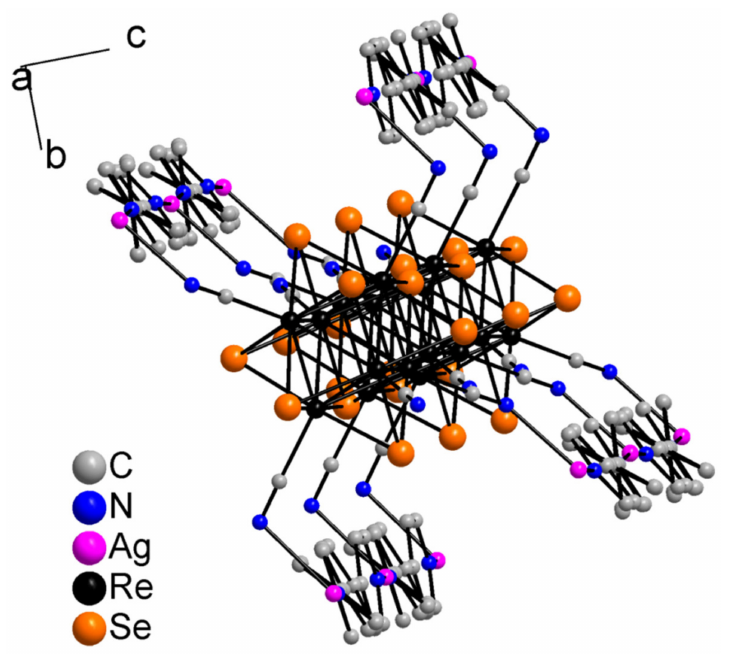
Figure 18. 1D fragment of compound 5 along a axis. 4,4 (cid:48) -Di(4-pyridyl)biphenyl is not a common ligand for the synthesis of